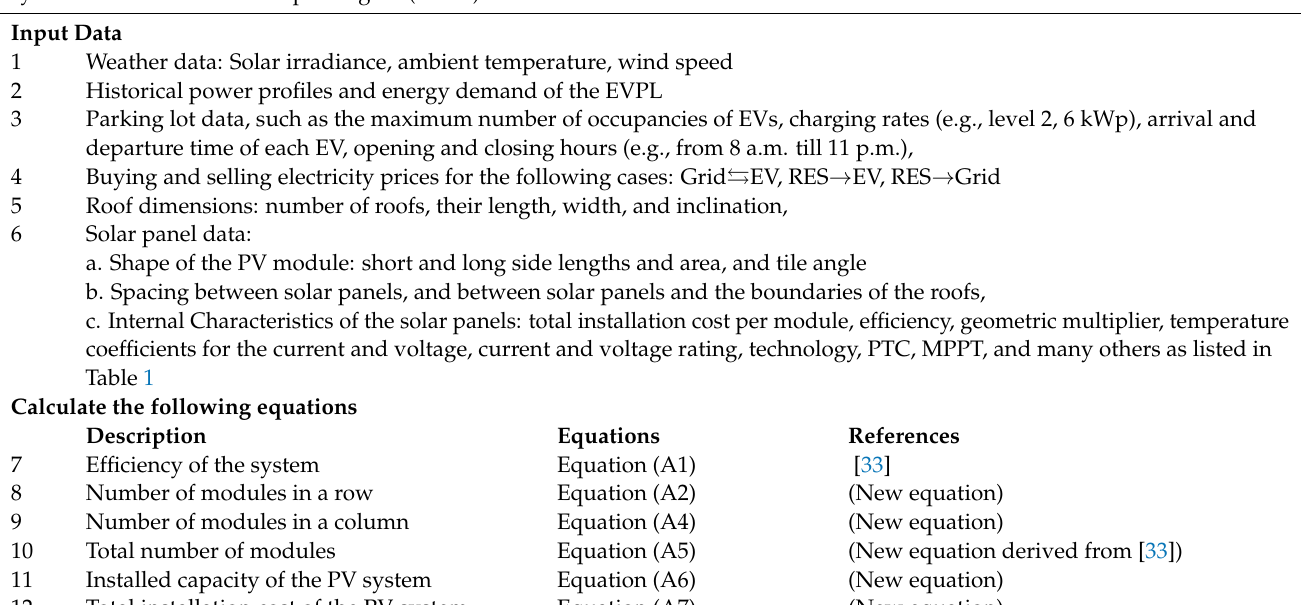
Algorithm 1. Proposed algorithm for optimal selection and distribution of the solar panels for a roof-mounted photovoltaic (PV) system in an electric vehicle parking lot